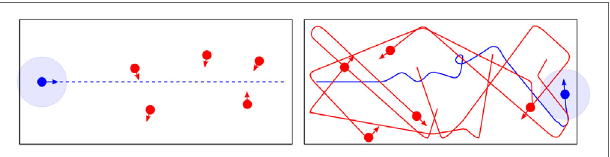
FigUre 1 | Illustration of the task. A smart robot (marked in blue) using the consequence engine CE has to traverse a corridor from left to right without colliding with the h-robots (marked in red). Solid lines show the past trajectories, and arrows represent the current movement direction of the robots. The light blue circle around the smart robot marks a safety (exclusion) zone. The left panel shows a set of initial conditions with the task depicted as a dashed line. The right panel shows the realized trajectories at the end of an episode of the experiment.